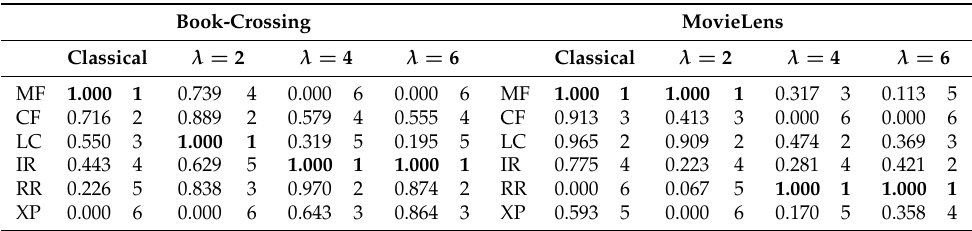
Table 4. Evolution of the accuracy scores (i.e., NDCG) of the different algorithms when comparing a classical random 10-fold bootstrap process (see the columns “Classical”) and our new model (see the columns λ = 2, λ = 4 and λ = 6). The left part of each column contains the normalized score (on the six rows of the column), while its right part contains the rank (from 1 to 6) of the algorithm (on the six rows of the column).